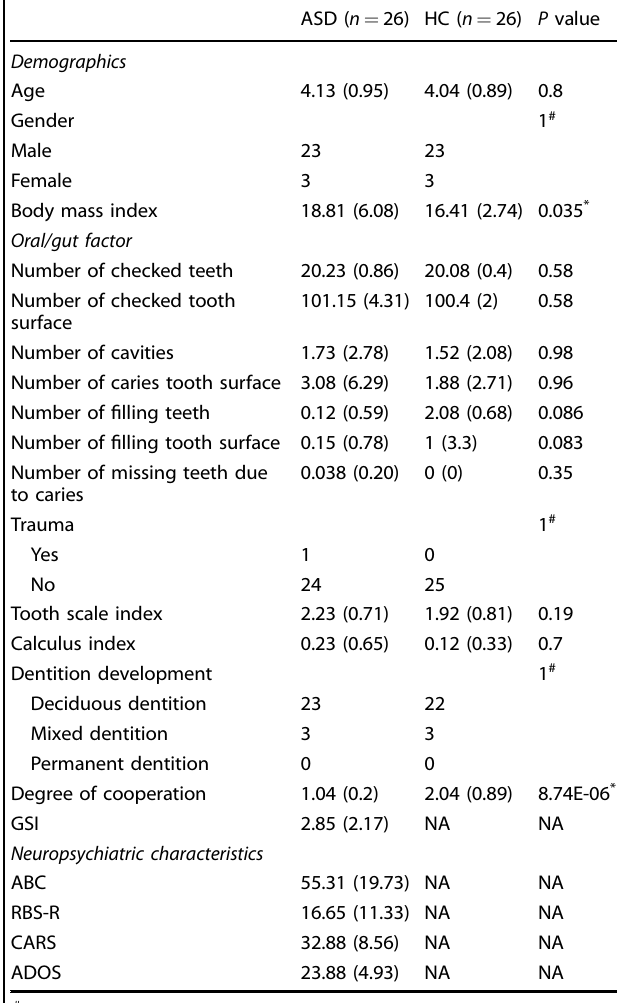
Table 1. Summary of subject characteristics for the samples included in the